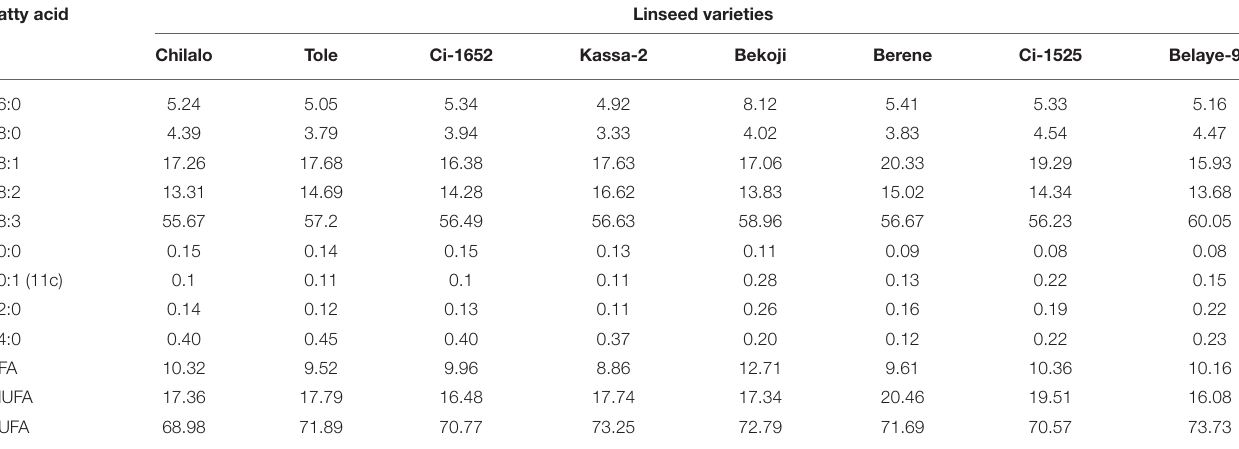
TABLE 2 | Fatty acid composition (%) of the linseed varieties. Fatty acid Linseed varieties